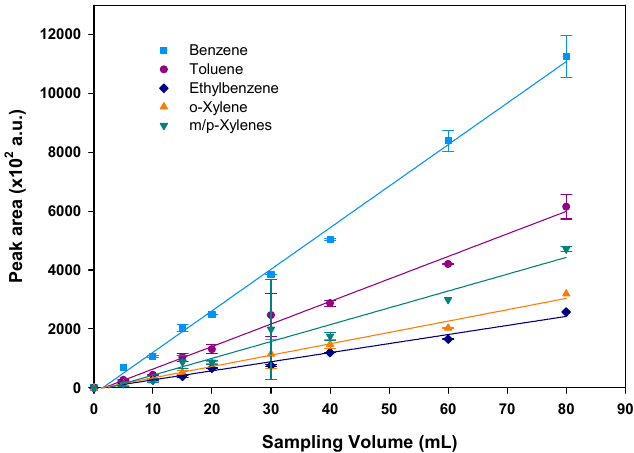
Figure 6. Peak area variation with sampling volume (BTEX concentration of 100 ppb). The vertical error bars show the standard deviation for duplicate injections.